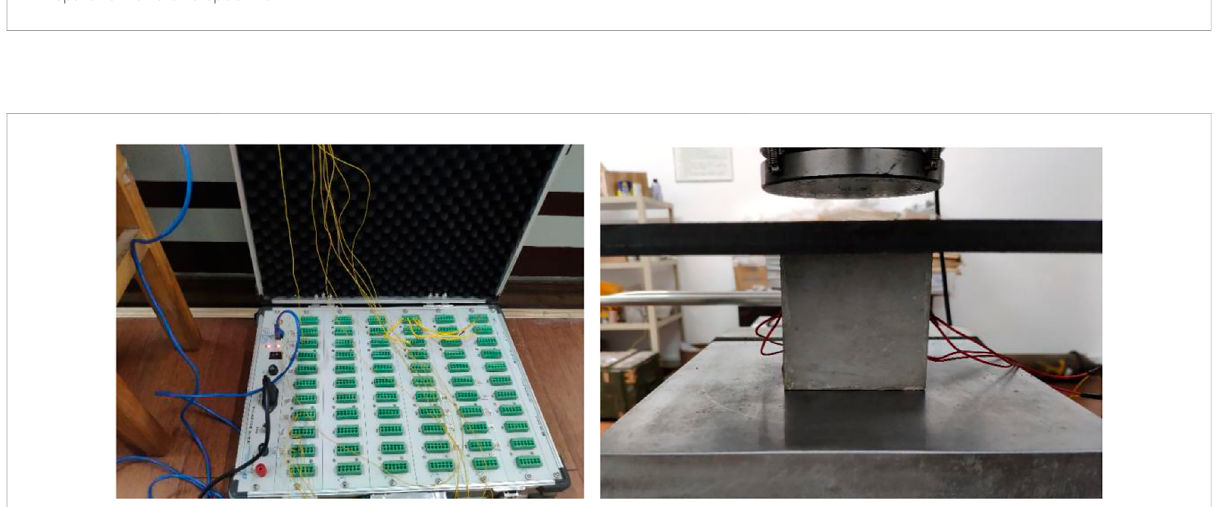
FIGURE 12 Preparation of stone specimen.